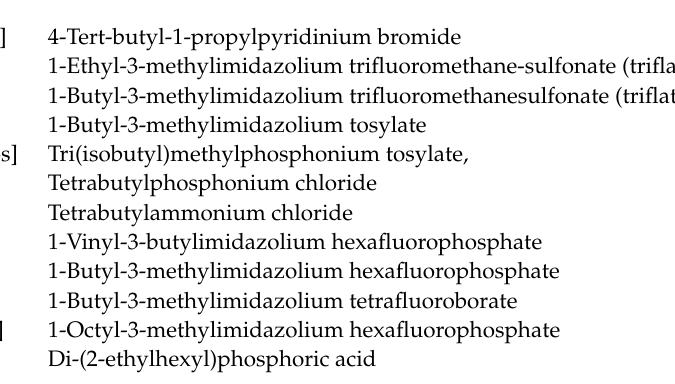
ology to screen ILs for Ibf; Figure S2 Schematic representation of ionic liquid based green emulsion liquid membrane; Figure S3 Calibration curve for Ibf using UV-vis; Figure S4 σ -profiles a)for cations and b) for anions under study; Figure S5 Regression curve for ACid and experimental extraction effi- ciency; Table S1 ILs used for the removal of Ibf; Table S2 Chemicals and reagents used; Table S3 ACid values predicted using COSMO-RS for ILs; Table S4 Capacity values predicted using COSMO-RS for ILs; Table S5 Selectivity values predictive using COSMO-RS for ILs; Table S6 Performance Index for different ILs; Table S7 Effect of alkyl chain length on the capacity of ILs; Table S8 Effect of alkyl chain length on the selectivity of